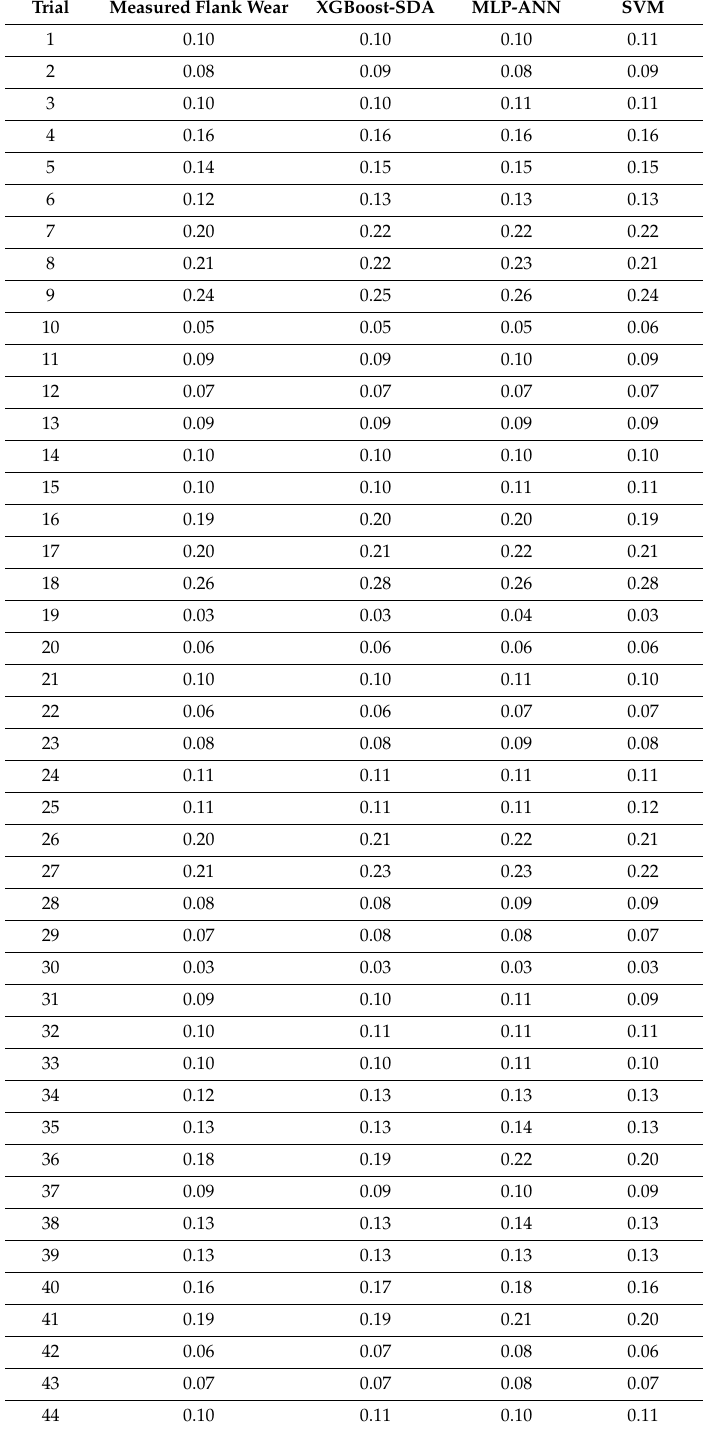
Table 6. Prediction results of the flank wear in the drilling process (Copper